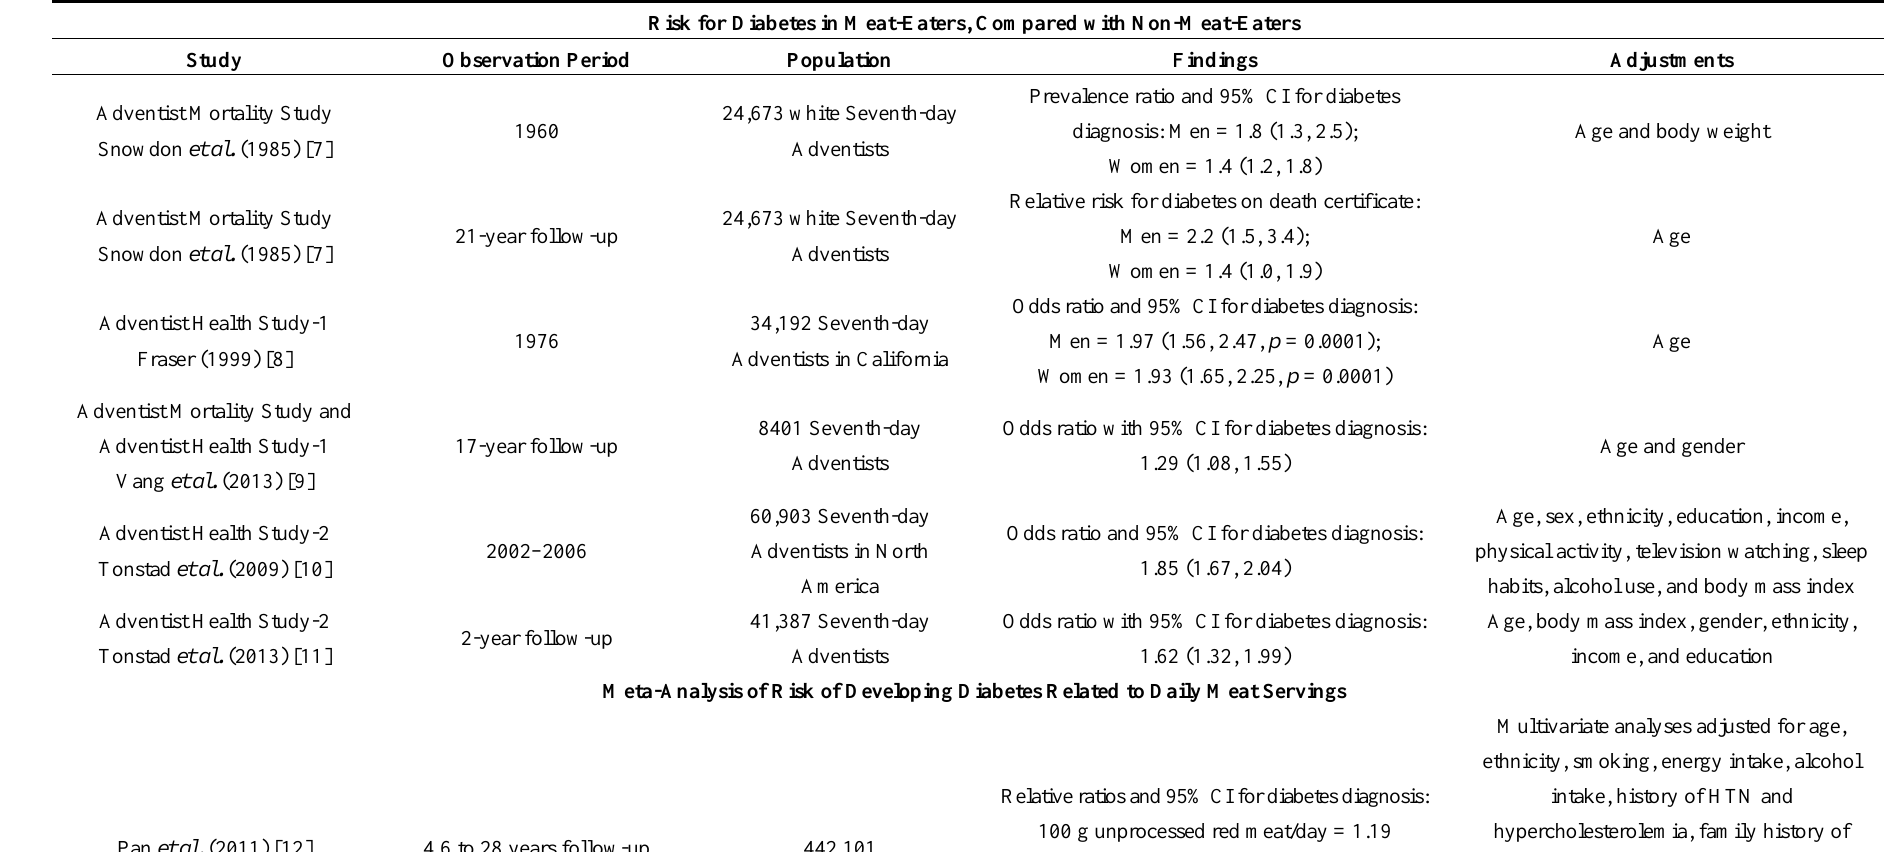
Table 1. Published studies of the relationship between meat consumption and risk of type 2 diabetes. Risk for Diabetes in Meat-Eaters, Compared with